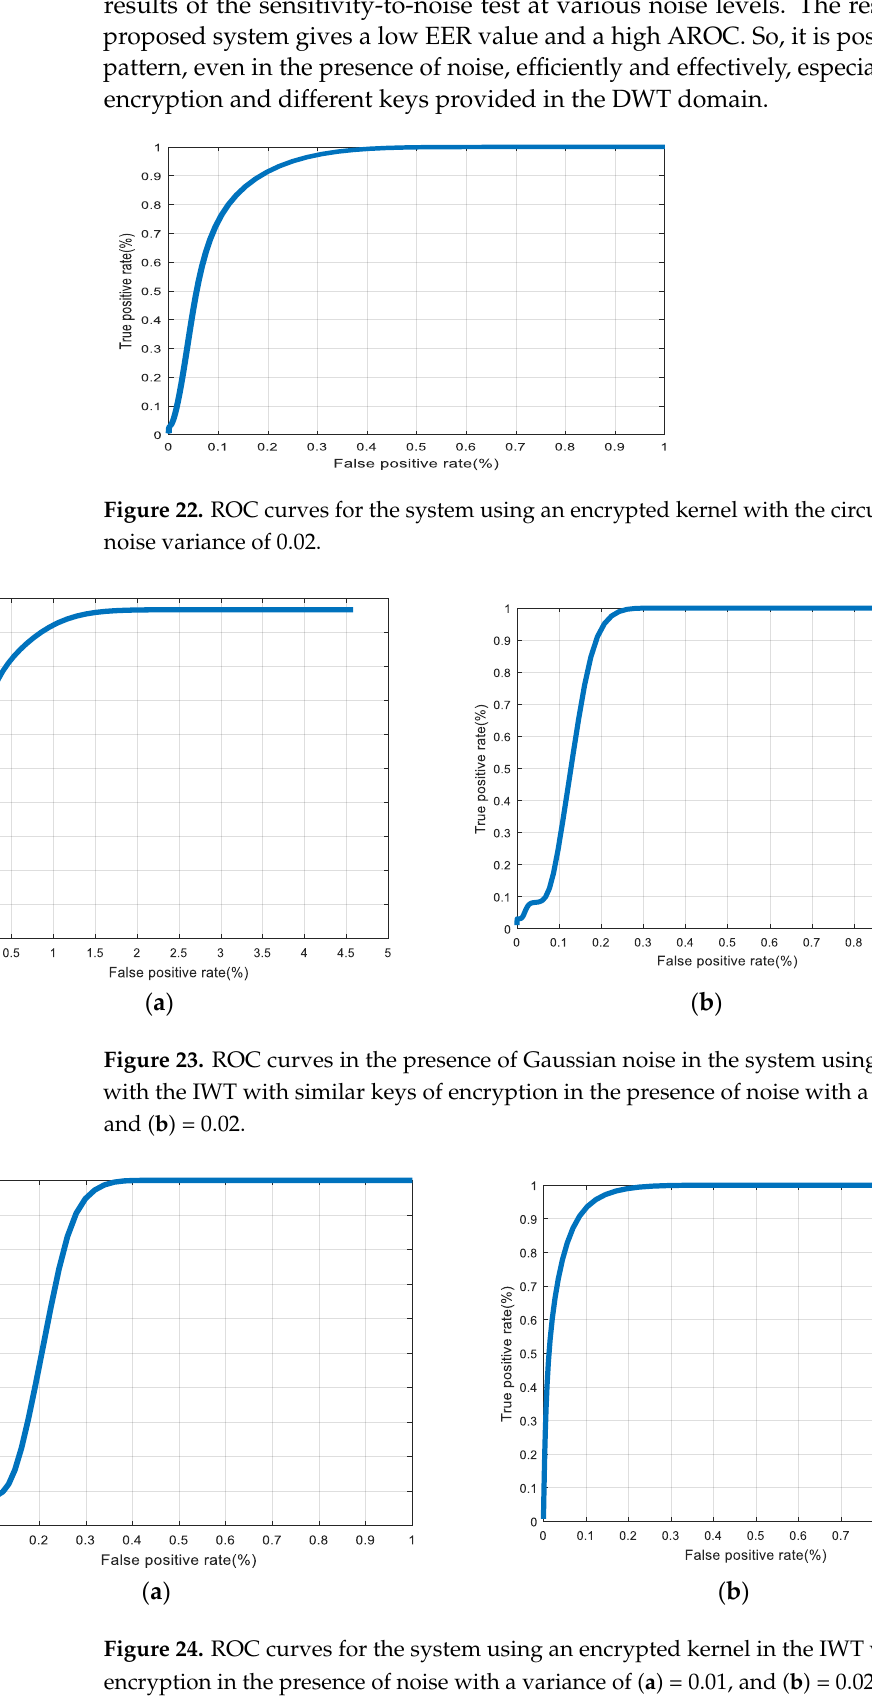
( b ) Figure 25. ROC curves for the system using an encrypted kernel in the DWT domain with similar keys of encryption in the presence of noise with a variance of ( a ) = 0.01, and ( b ) = 0.02. ( a )